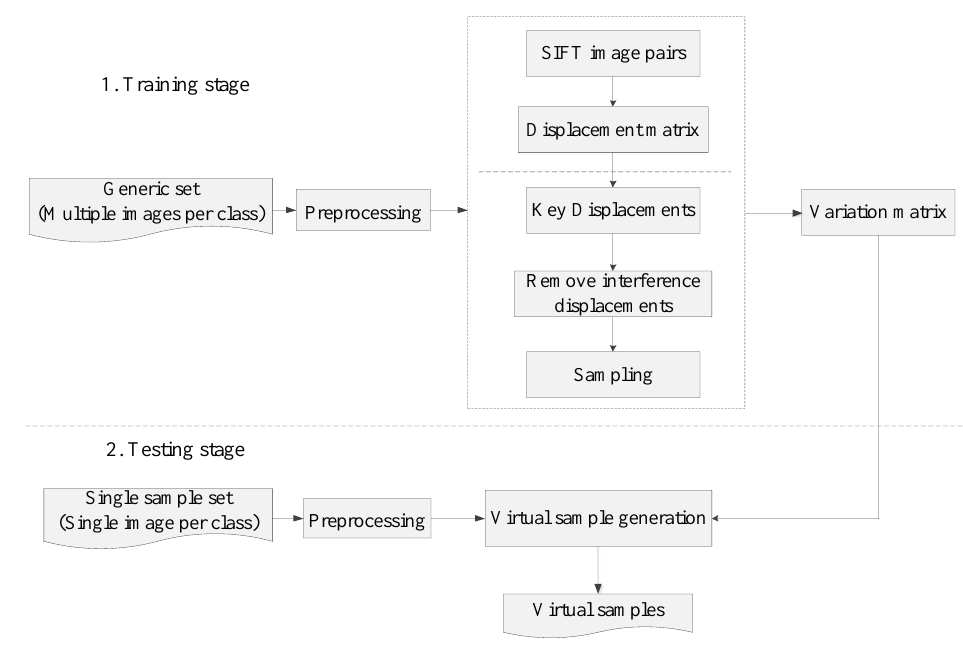
Figure 1. Schematic diagram of the virtual sample generation process.